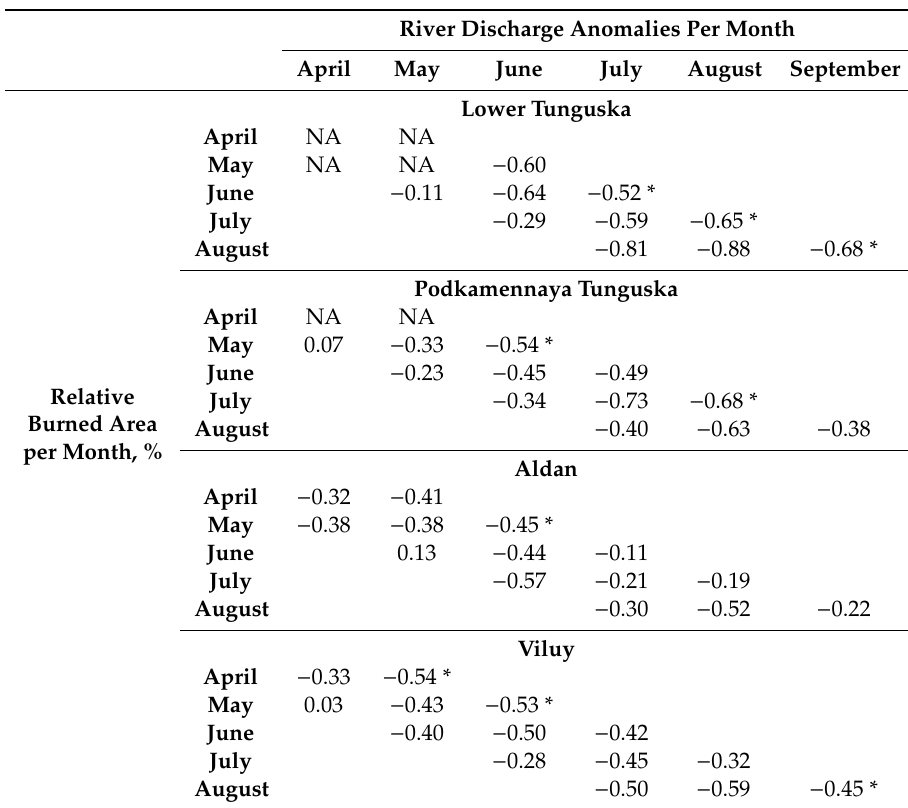
Table 3. The correlation matrix for RBA vs. the discharge